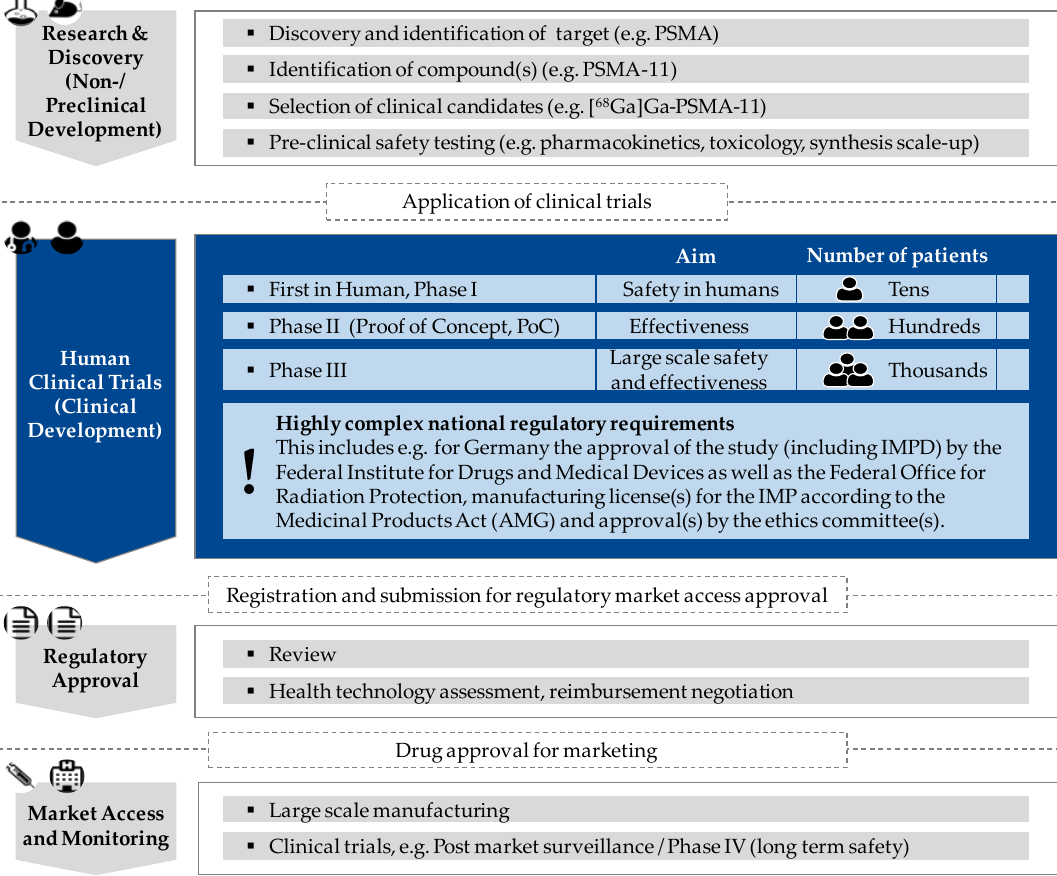
Figure 1. Schematic visualization of essential phases to be passed in the research and approval process of newly developed prostate-specific membrane antigen (PSMA)-radiopharmaceuticals / PSMA- radioligands with characteristics according to clinical trial phase; focus of the present study (clinical trial phase) in “blue”.